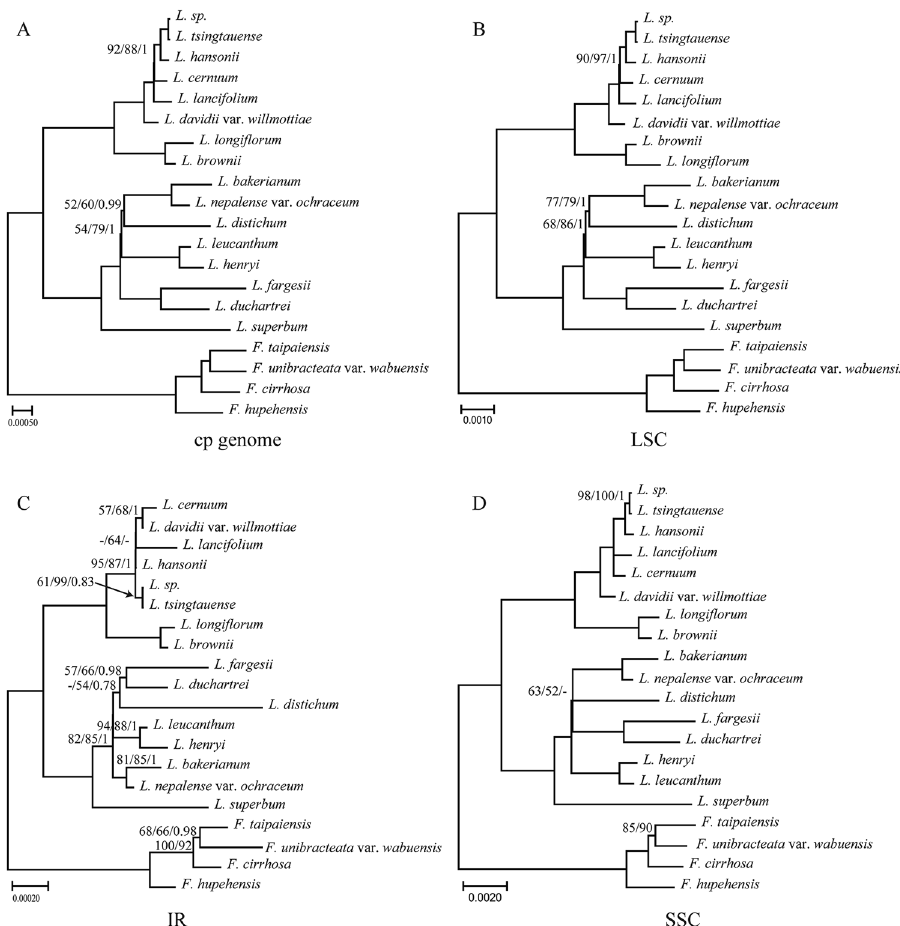
Figure 4. Phylogenetic relationships of the 16 Lilium species inferred from maximum parsimony (MP), maximum likelihood (ML) and Bayesian (BI) analyses of different data partitions. ( A ) Whole chloroplast genome. ( B ) LSC region. ( C ) IR region. ( D ) SSC region. Numbers above nodes are support values with MP bootstrap values on the left, ML bootstrap values in the middle, and Bayesian posterior probabilities (PP) values on the right.